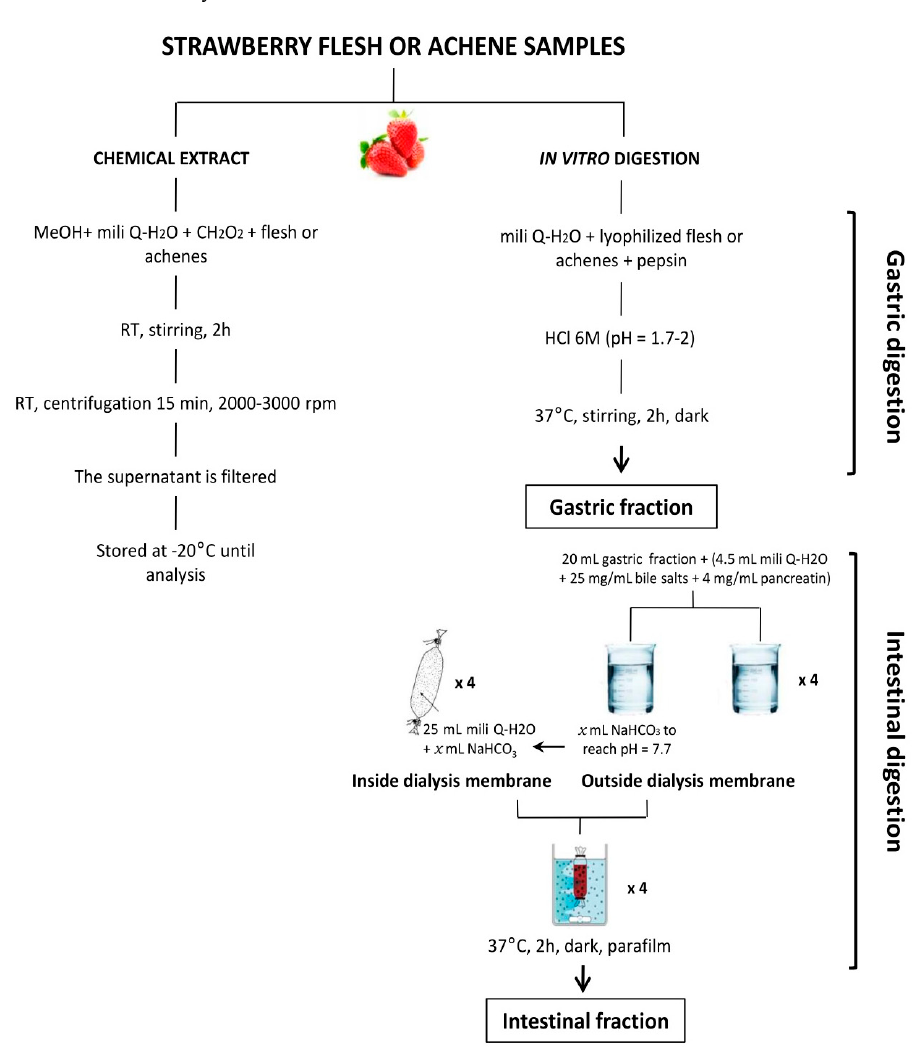
Figure 3. Scheme of the in vitro digestion general procedure used with strawberry and achene samples.